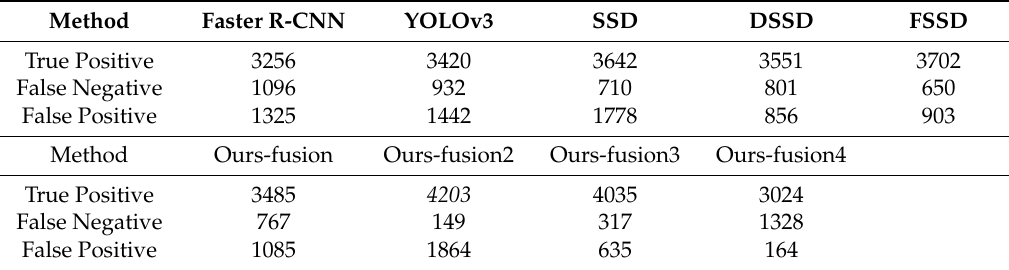
Table 4. Performance comparisons of seven different methods in terms of True Positive, False Negative and False